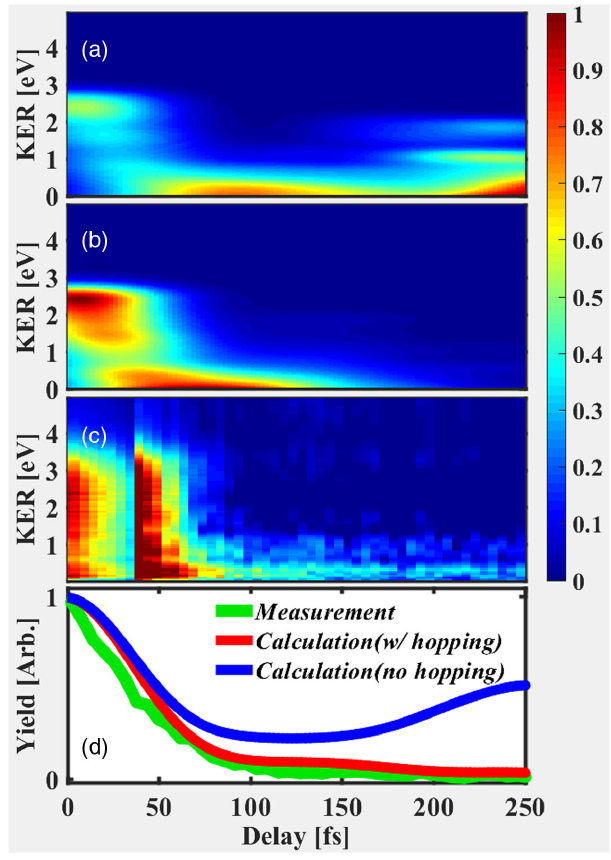
FIG. 15. Comparison between measured photoelectron spectra and calculations with or without surface hopping. (a) Calculated TRPES without surface hopping between different electronic states. (b) Calculated TRPES including surface hopping between different electronic states. (c) Measured TRPES. (d) Measured and calculated (with and without surface hopping) energy- integrated photoelectron yield as a function of pump-probe